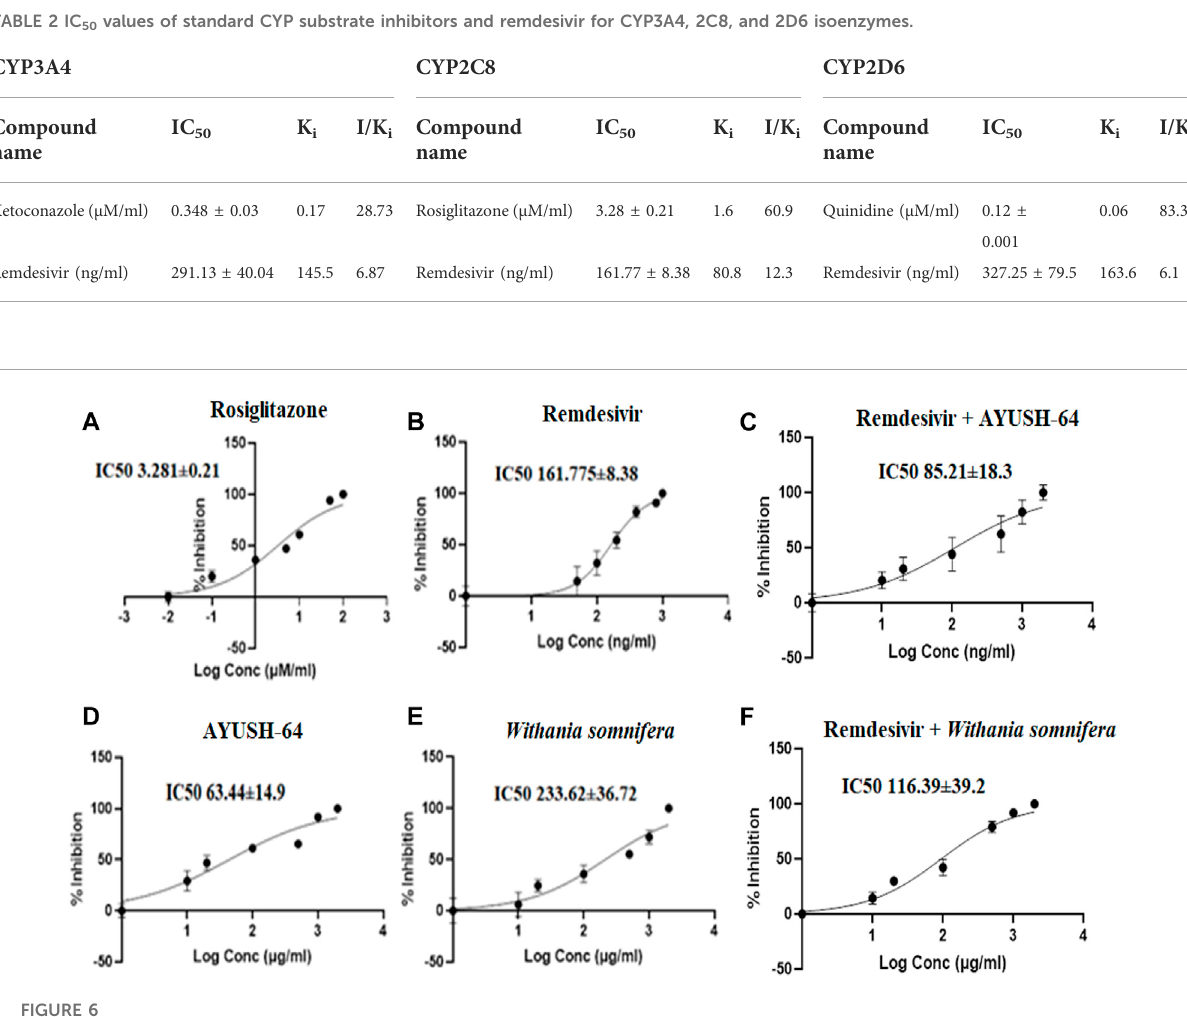
FIGURE 6 Effect of (A) rosiglitazone (100 – 0.01 μ M/ml), (B) remdesivir (1,000 – 1 ng/ml), (C) remdesivir + AYUSH-64 (2001 – 1.001 μ g/ml), (D) AYUSH-64 (2000 – 1 μ g/ml), (E) Withania somnifera (2000 – 1 μ g/ml), and (F) remdesivir + Withania somnifera (2001 – 1.001 μ g/ml) on CYP2C8-mediated hydroxylation of paclitaxel. The graphs have been plotted for log conc. vs . percentage of